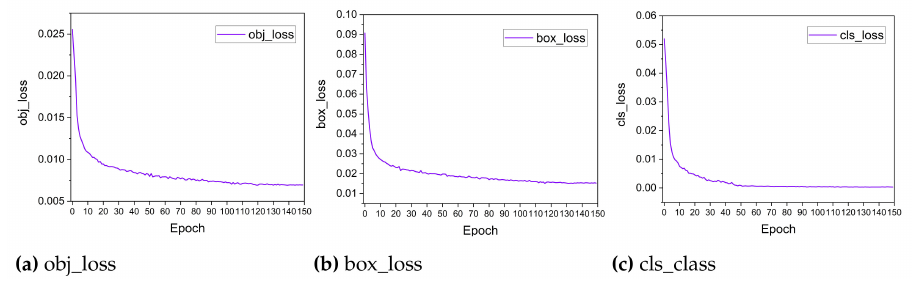
Figure 8. MS-YOLOv5 three types of training losses.